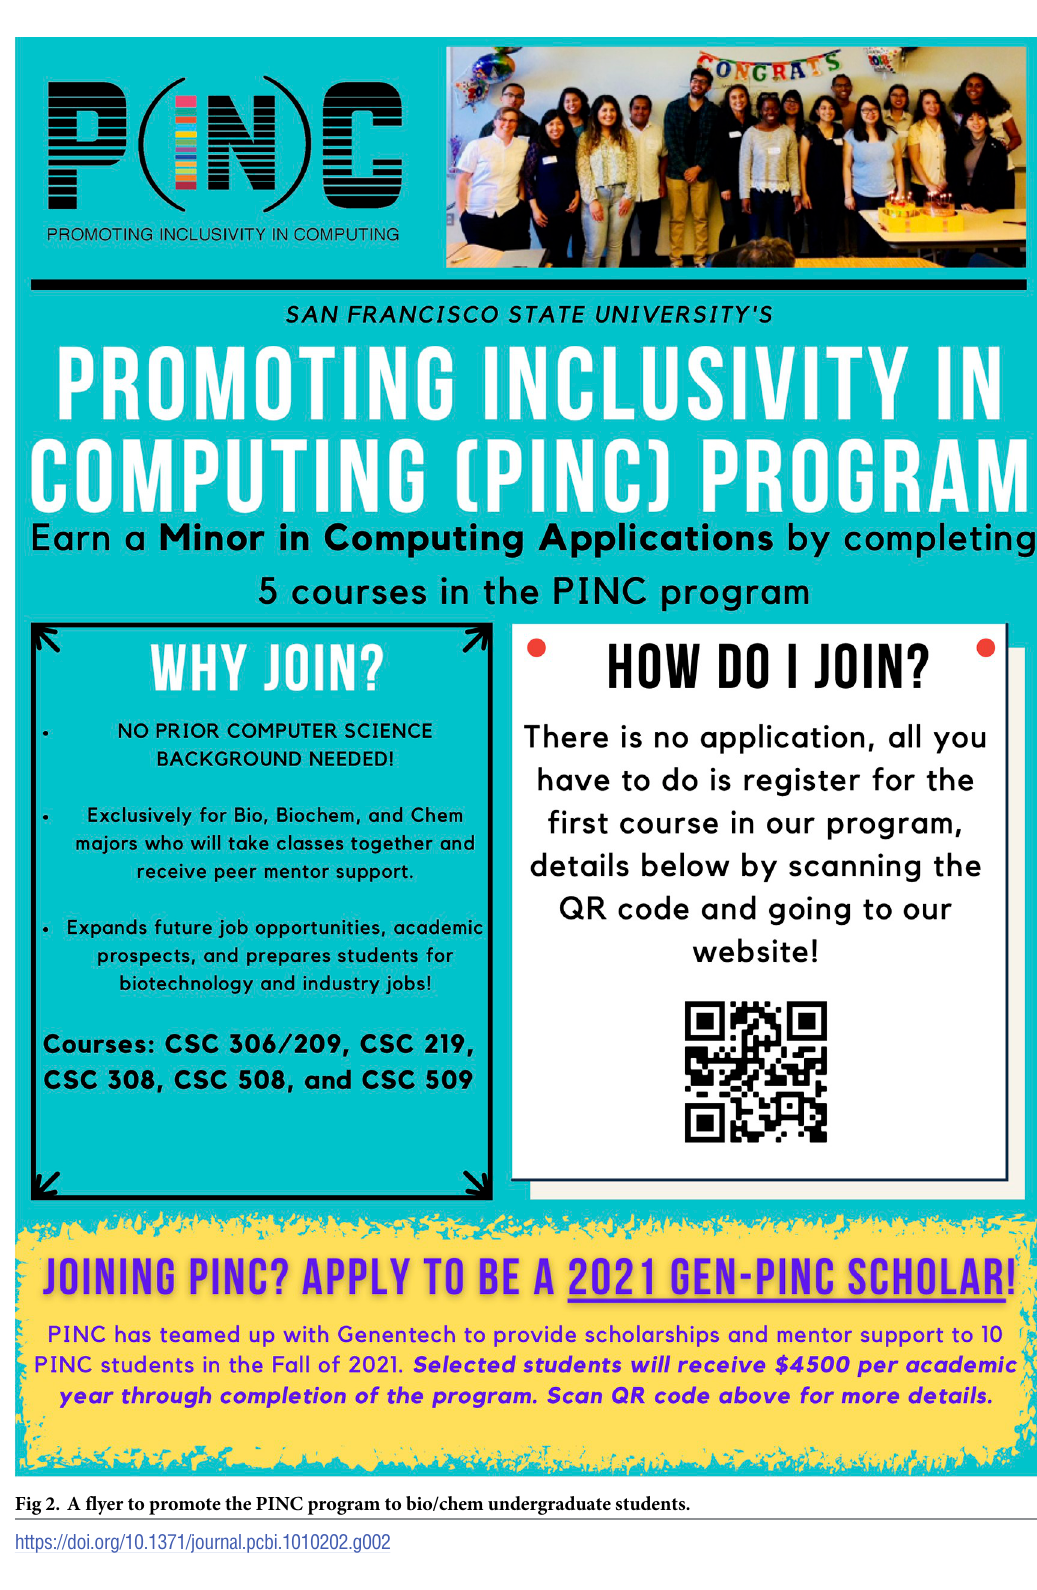
Fig 2. A flyer to promote the PINC program to bio/chem undergraduate